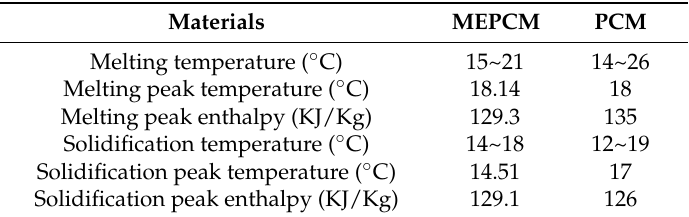
Table 1. The properties of two phase change materials.